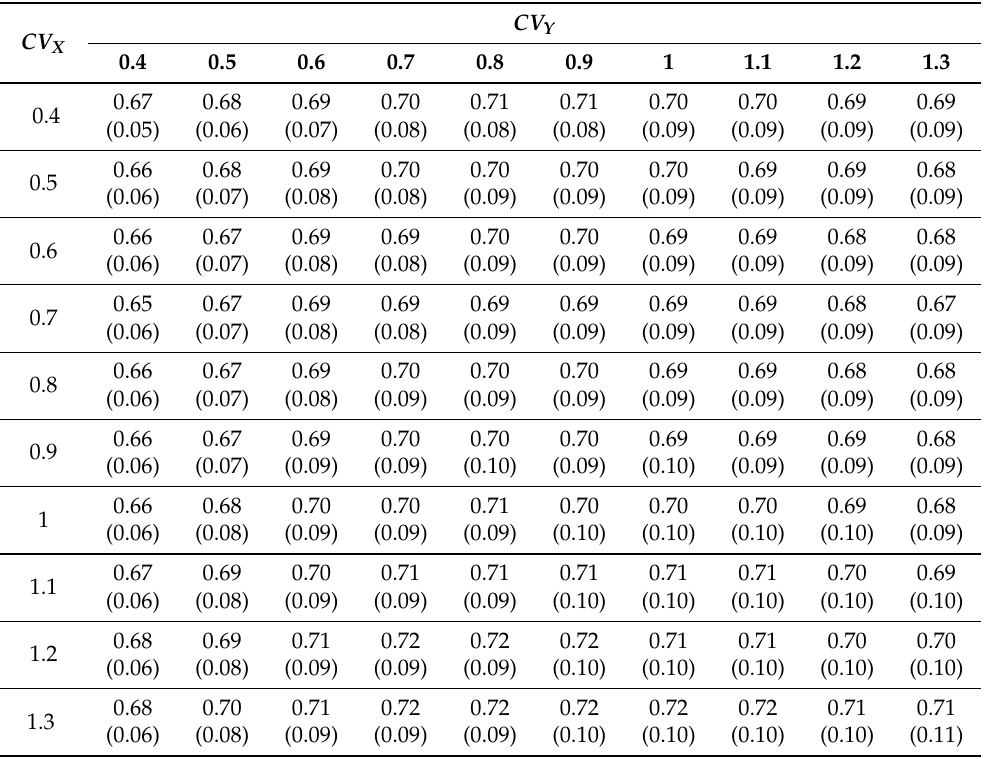
Table A2. Simulation of the ratio distribution: mean values of the fractional moment of the fourth order and standard deviations (in brackets) for 5000 values of 10 pairs of observations X i / Y i , where X i ∼ N ( µ X , σ X ) and Y i ∼ N ( µ Y , σ Y ) , under varying coefficients of variation (CV), with ( µ X / µ Y ) 1/4 =